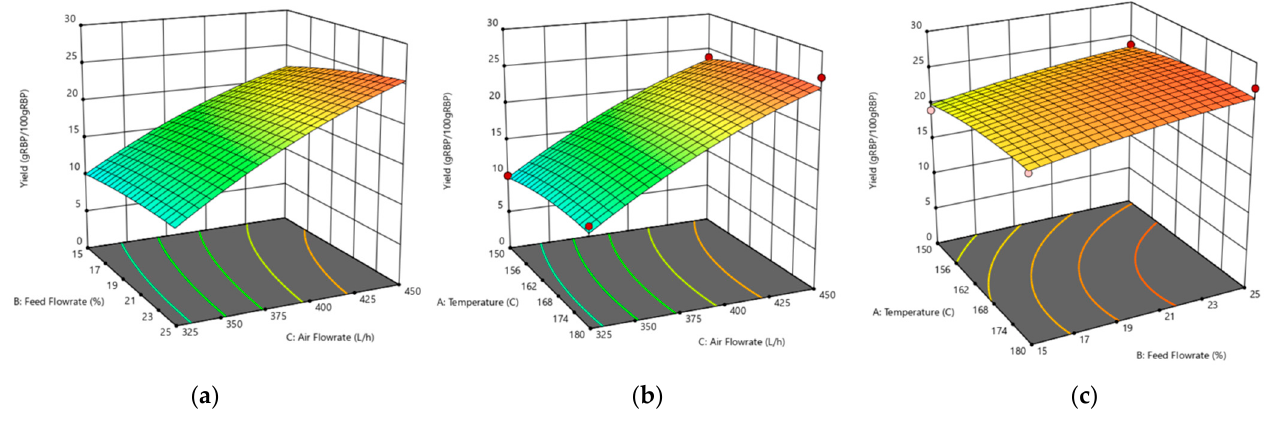
Figure 5. Three-dimensional response surface model plot for RBP powder yield at constant ( a ) Inlet temperature of 178 °C. ( b ) Feed flowrate of 25%. ( c ) Air flowrate of 450 L/h. Table 1. Model validation with experimental